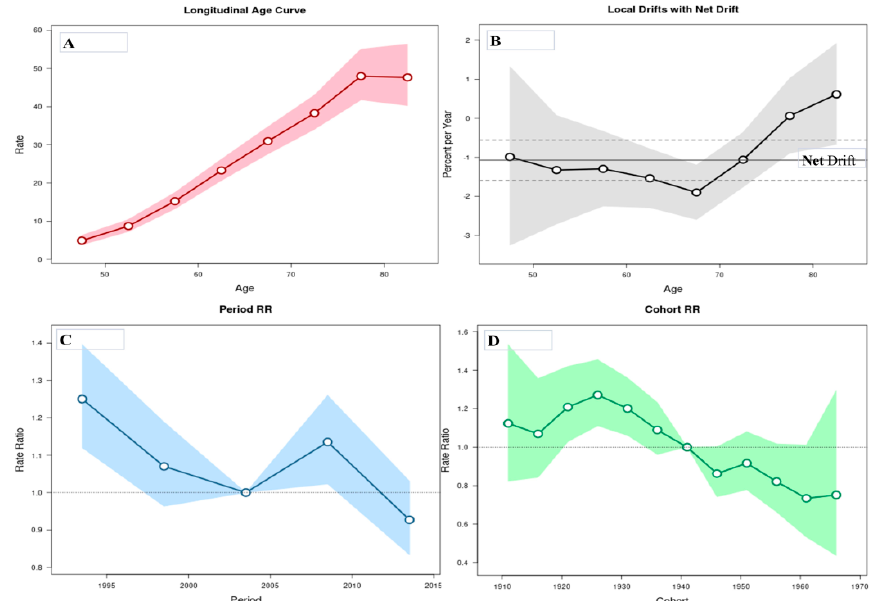
Figure 3. Liver cancer mortality rates in Serbia, 1991–2015: An age-period-cohort analysis. ( A ) Longitudinal age curve of liver cancer mortality rates (per 100,000 people) and 95% confidence intervals (the area colored in pink). ( B ) Local drift value: age group-specific annual percent change (%) and 95% confidence intervals (the area colored in grey), and net drift. ( C ) Period effects for the liver cancer mortality rates and 95% confidence intervals (the area colored in blue); RR—rate ratio. ( D ) Cohort effects for the liver cancer mortality rates and 95% confidence intervals (the area colored in green) ; RR—rate ratio. Table 3. Age, period, and cohort e ff ects on liver cancer mortality in Serbia, 1991–2015, by gender.